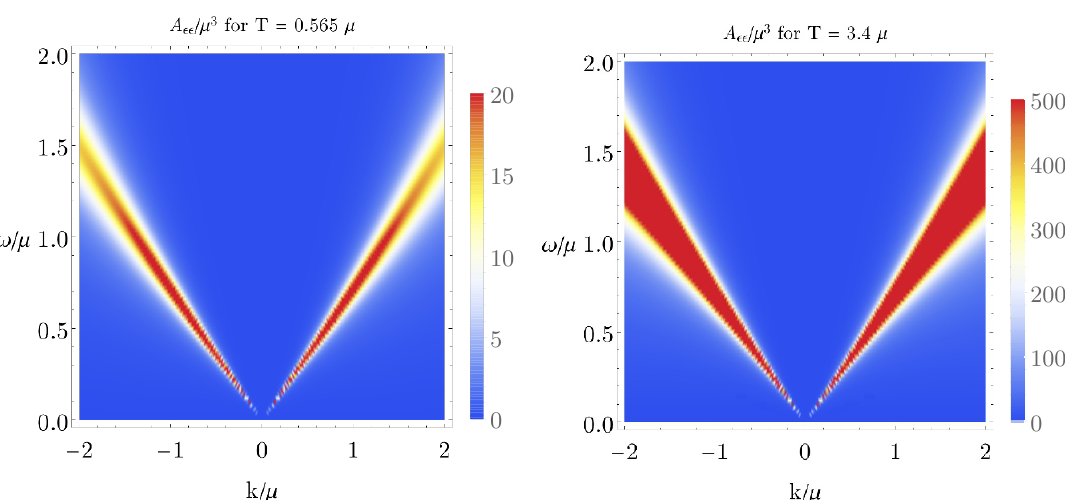
Figure 2. The energy-density spectral function for two di(cid:11)erent values of the temperature in 2 + 1 dimensions. The sound modes are clearly visible and we can notice that the associated peaks become higher for a higher value of the temperature.